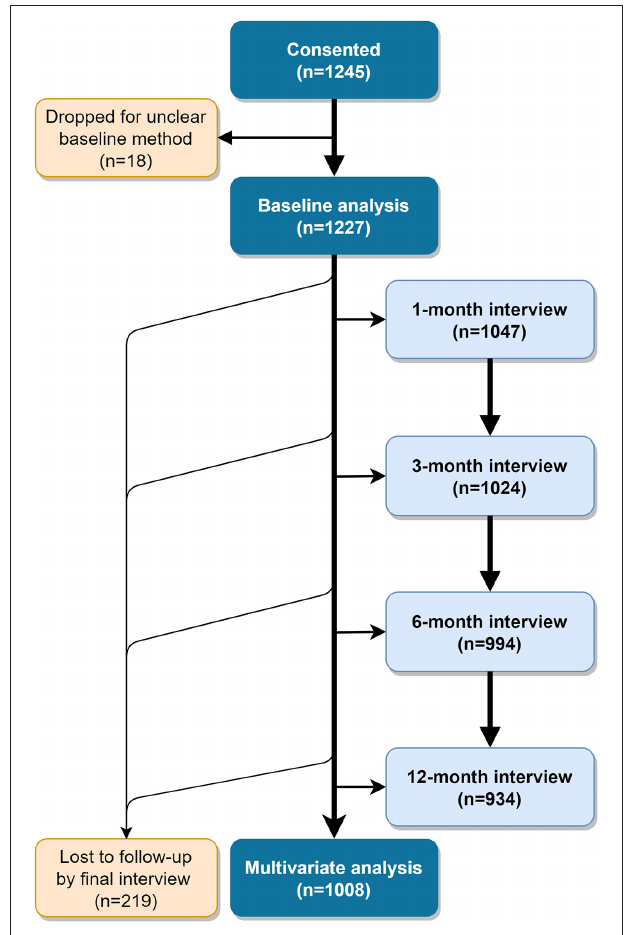
FIGURE 1 | Participant flow